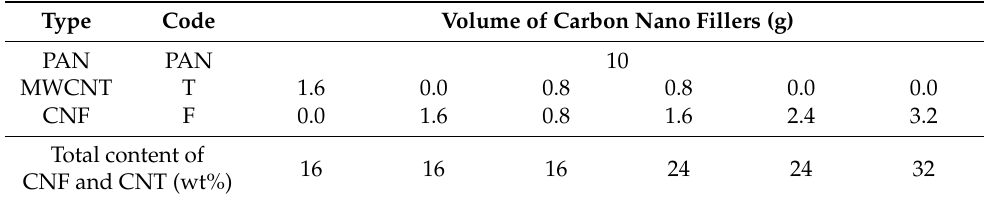
Table 2. Composition of CNF and CNT for the conductive composite solution.